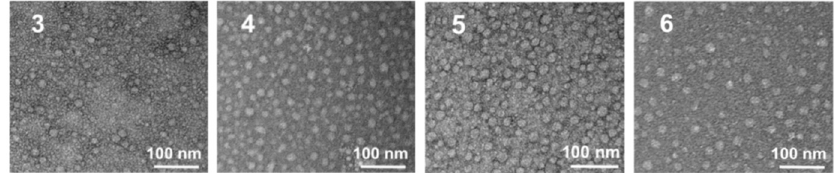
Figure 2. TEM images of spherical micelles formed by the amphiphilic dendrons 3 – 6 . Adapted from [7] with the permission of John Wiley and Sons, 2016.